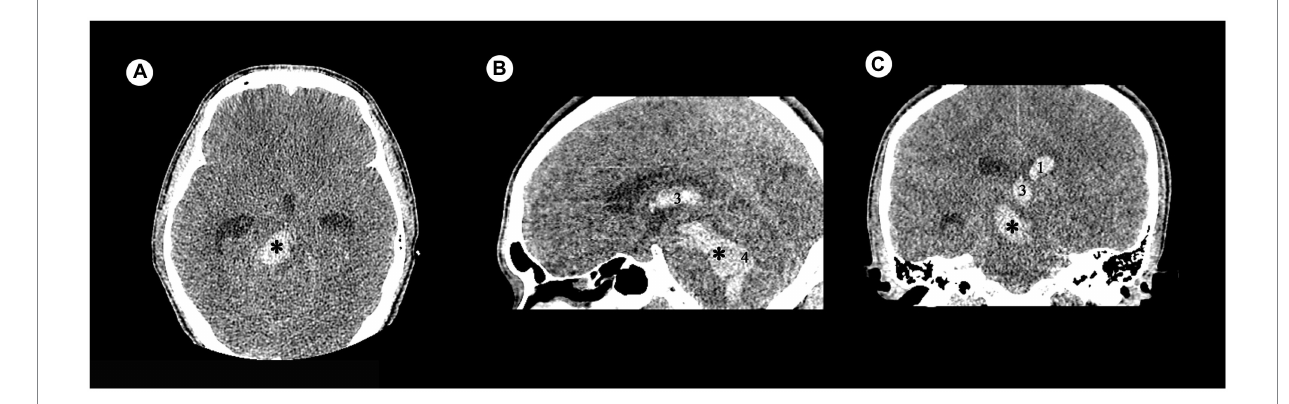
FIGURE 2 Examples of hemorrhage involving the ventricular system in patients with acute obstructive hydrocephalus detected by craniofacial computer tomography (CT) scans. (A) Transverse view: Hematoma was present in brainstem ( ✱ ). (B) Sagittal view: Hematomas were present in brainstem ( ✱ ), third ventricle (3), and fourth ventricle (4). (C) Coronary view: Hematomas were present in brainstem ( ✱ ), third ventricle (3), and lateral ventricle (1).